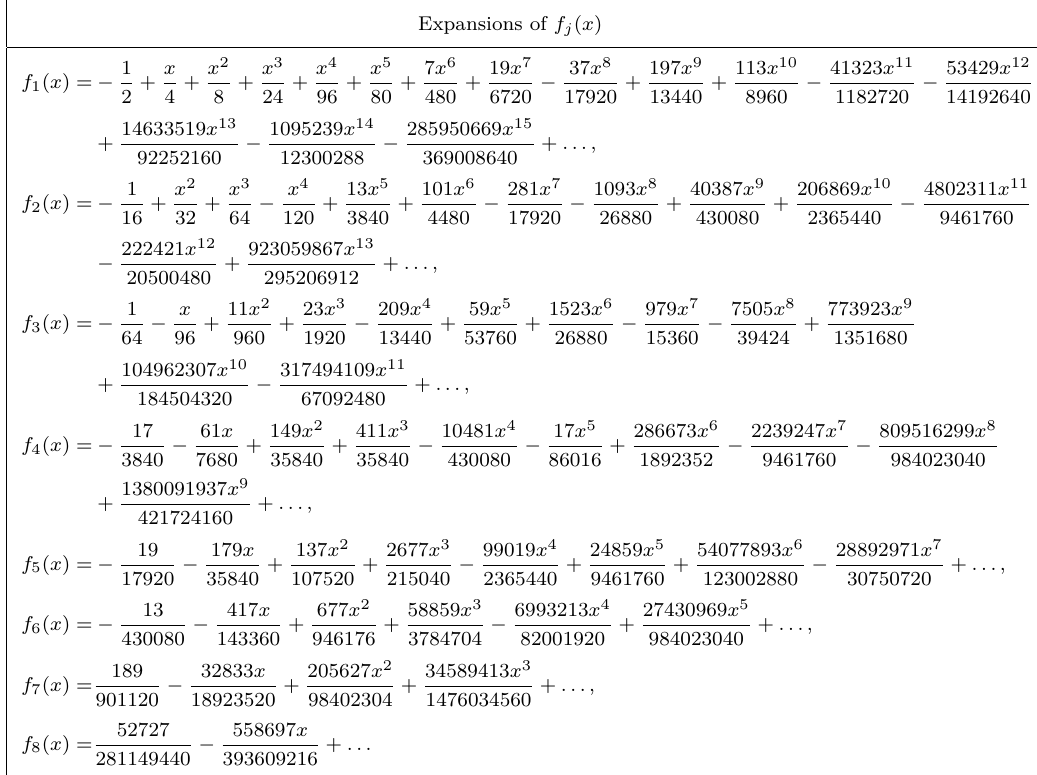
Table 1 . Power series expansion of the first few f j s appearing in eqs. (3.21) and (3.27). These